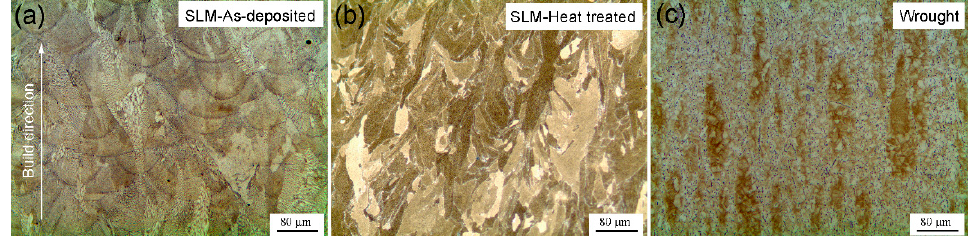
Figure 2. Optical microscopy (OM) images for the planes parallel to the build direction for ( a ) as-deposited selective laser melting (SLM) IN718, ( b ) SLM plus heat treatment (SLM-HT) and ( c ) wrought specimens.